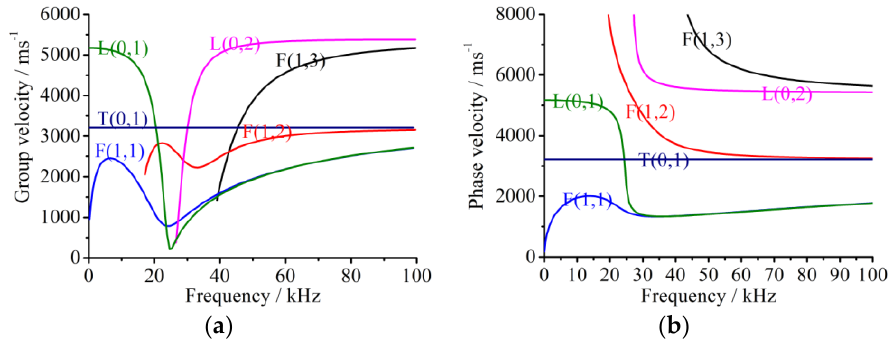
Figure 2. Dispersion curves of a steel pipe with an outside diameter of 70 mm and wall thickness of 4 mm. ( a ) Group velocity curves; ( b ) Phase velocity curves. mm. ( a ) Group velocity curves; ( b ) Phase velocity